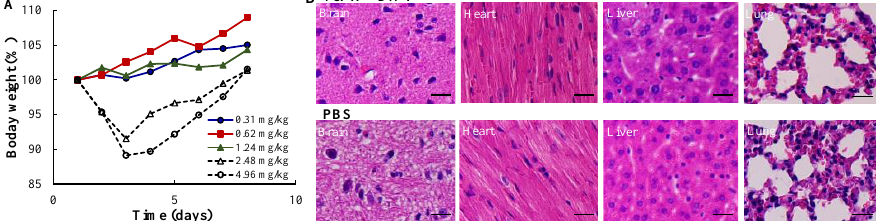
Figure 4. Maximum tolerated dose (MTD) and toxicity analysis of SSTR2/CXCR4 dual-targeted mAbs-EV-ver-A/DM1. ( A ) MTD to test the effect of five dosages including 0.31, 0.62, 1.24, 2.48, 4.96 mg/kg. n = 3. ( B ) Haematoxylin and eosin (H&E) staining of main organs, including brain, heart, liver and lung. Scale bar equals to 20 µm.